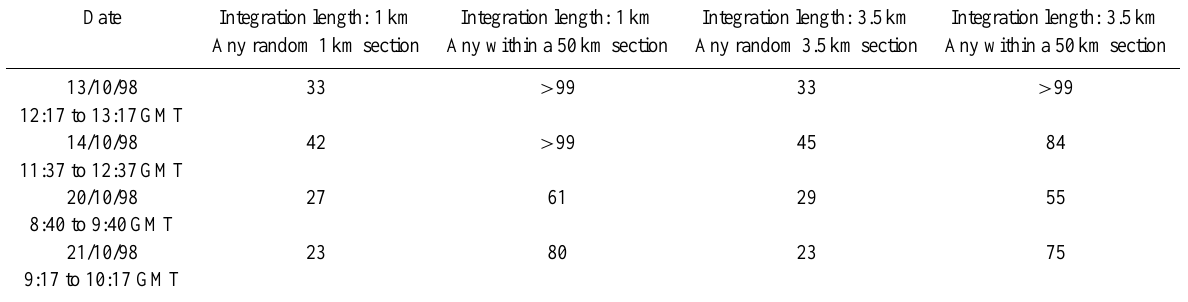
Table 1. The probability of obtaining at least one pixel of mean height between 1.0 and 1.5km that has a reflectivity in the range 800 to